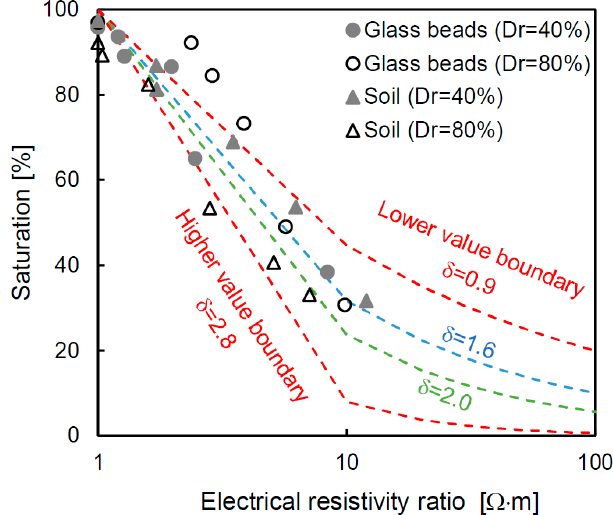
Figure 8. Electrical resistivity ratio versus saturation. The electrical resistivity ratio denotes the relationship between the electrical resistivity of the specimen and the electrical resistivity of the same specimen under the 100% saturated condition. The saturation factors ( δ ) of 1.6 [43] and 2.0 [35]. The values of the upper and lower boundaries are based on the measured data in this study.